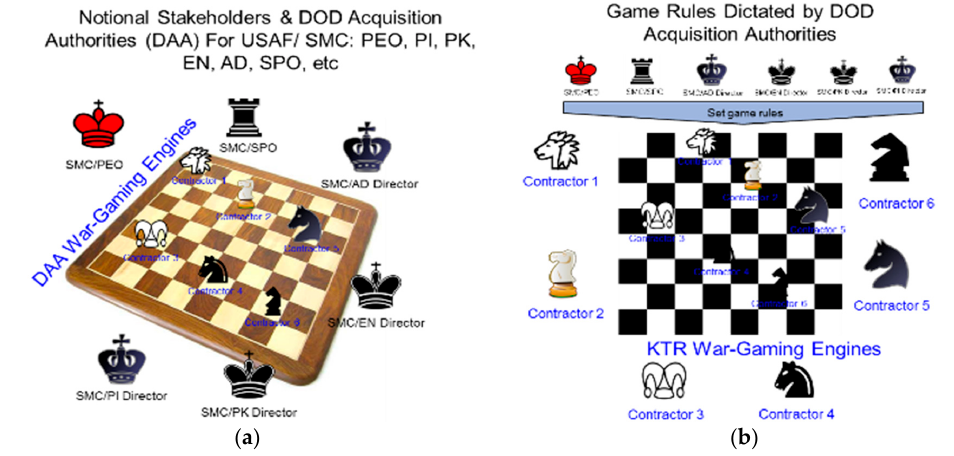
Figure 1. A Proposed Vision for War-Gaming Applications [3]: War-Gaming Engines to be palyed by ( a ) Stakeholders & DoD acquisition Authorities; ( b ) Contractors